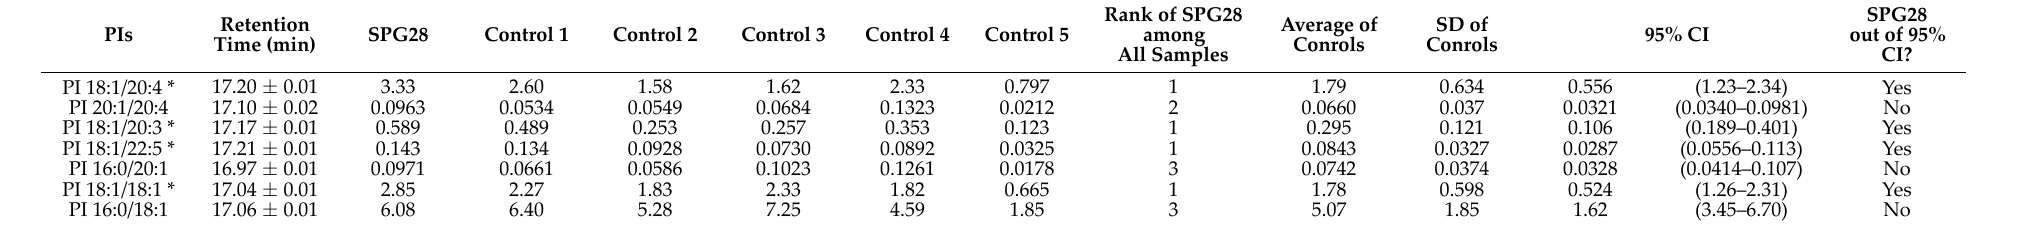
Table 4. Results in human sera for PIs significantly changed in Ddhd1 ( − / − ).